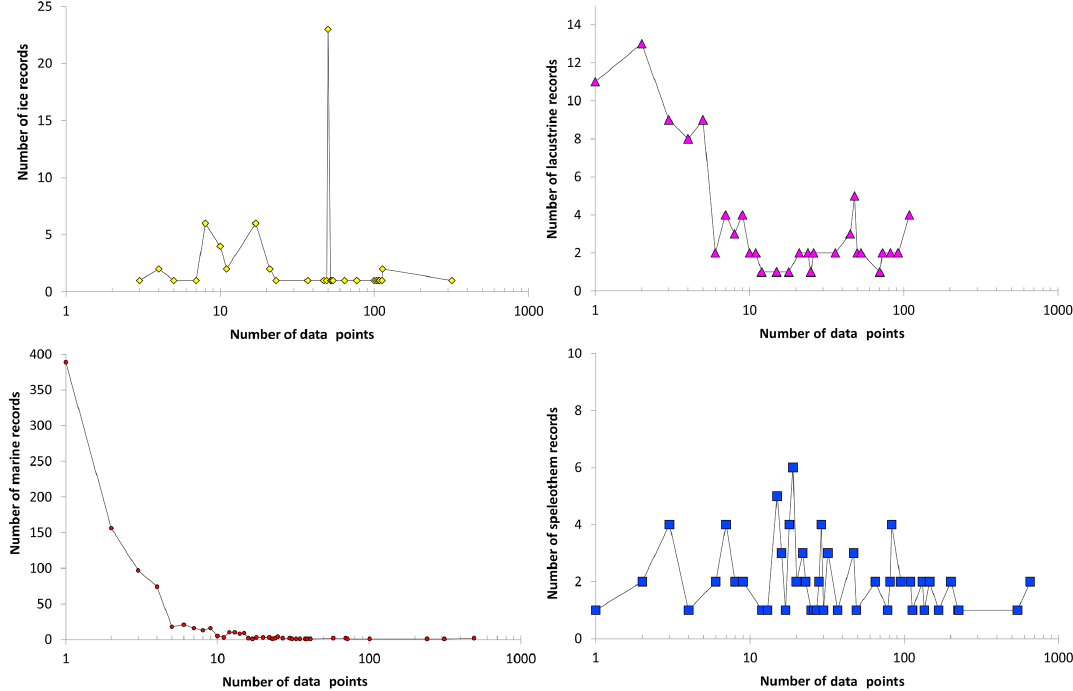
Figure A2. Same as Fig. 1 but for the mid-Holocene (5.5–6.5ka). Note the different vertical scales.